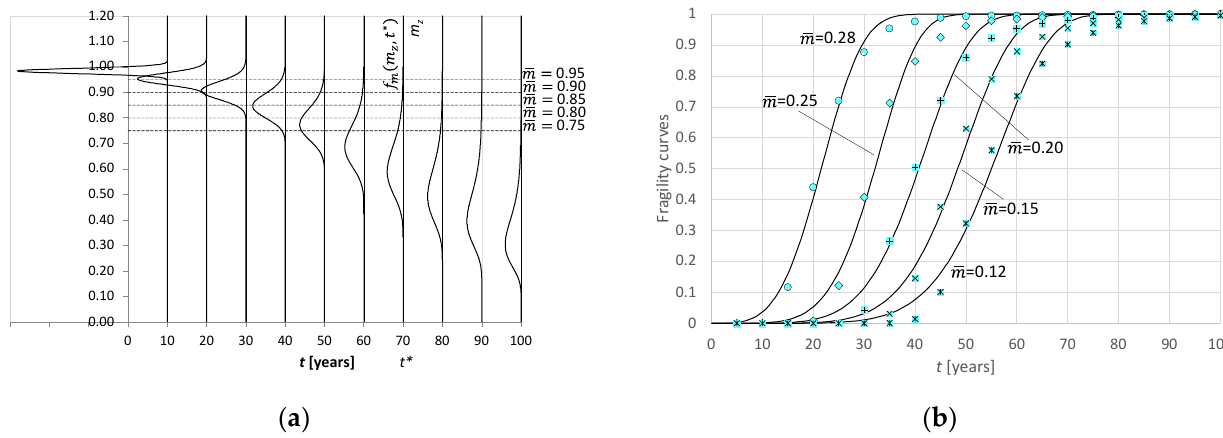
Figure 5. “Statistical truth” for e m z : ( a ) Exceedance probability of reaching the threshold m defined by F m ( m z , t ∗ ) ; ( b ) experimental (symbols) and theoretical (lines) fragility curves, F m